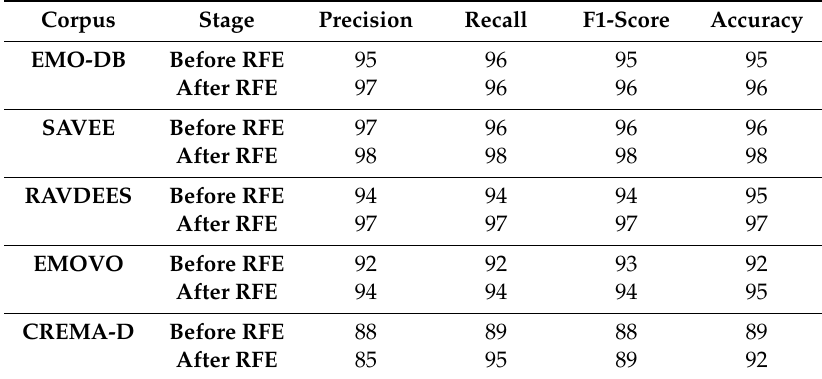
Table 9. Percentage precision, recall and F1-score and accuracy of RALOG on individual corpus at each experimental stage of feature scaling with the RF-RFE algorithm. Corpus Stage Recall